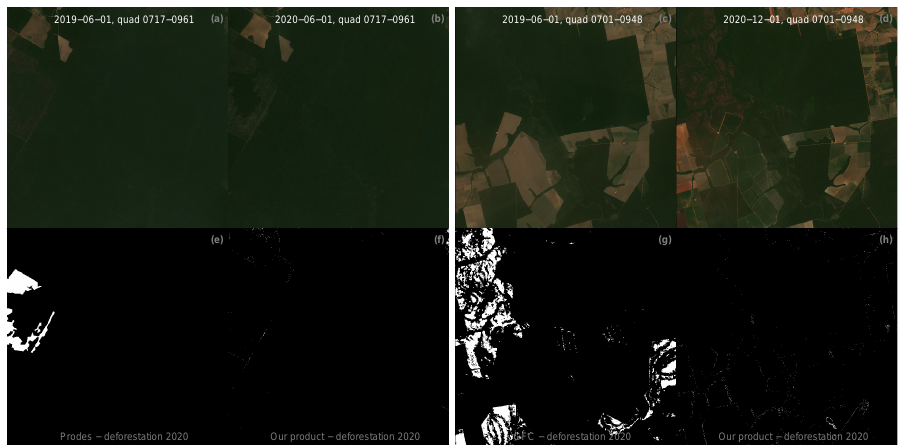
Figure 8. Example of poor agreement, i.e., < 10% of intersection, of our deforestation product and the PRODES data (planet quad 0717-0961) and GFC “tree loss year” data (planet quad 0701-09948) for the year 2020. Planet NICFI quad is